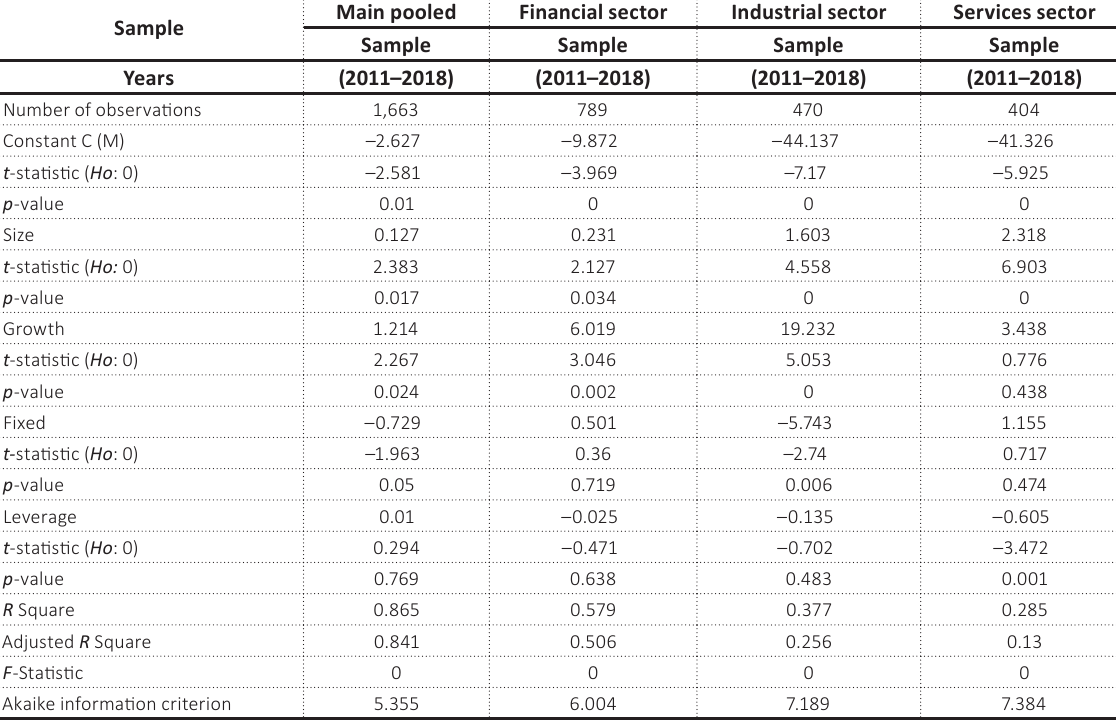
Table 6. Determinants of firms’ profitability: pooled data and the three main sectors